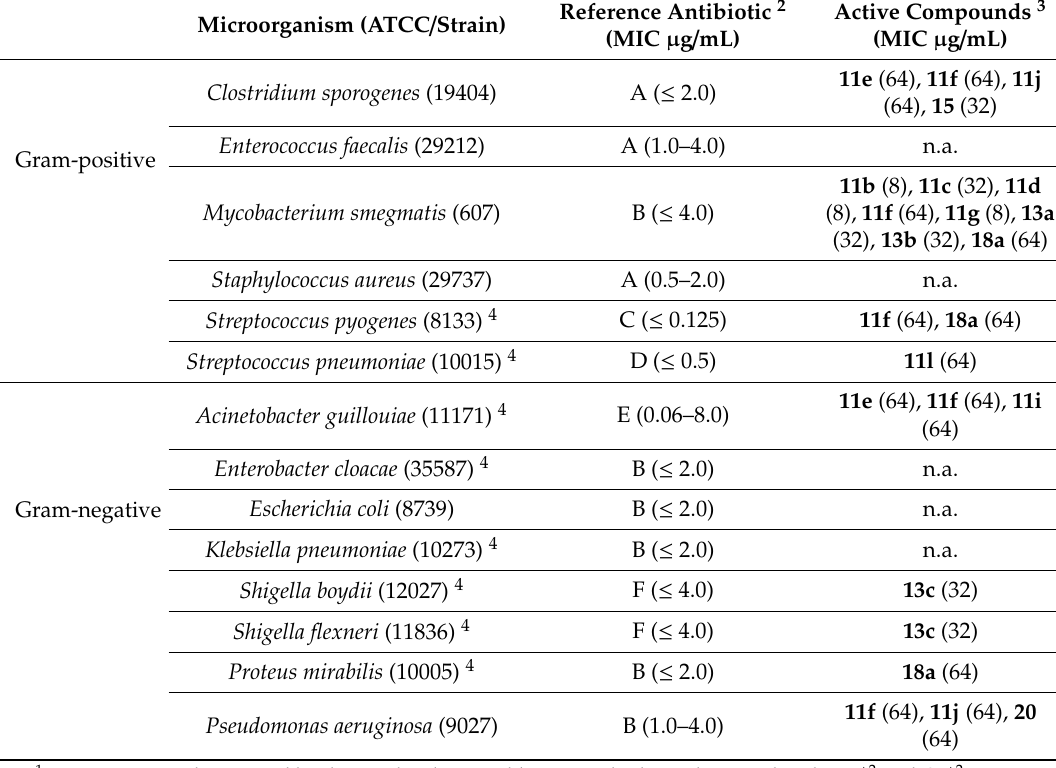
Table 2. Antibacterial activity of compounds 11a – 11m , 13a – 13c , 15 , 18a – 18b , and 19 – 23 1 . Microorganism (ATCC /